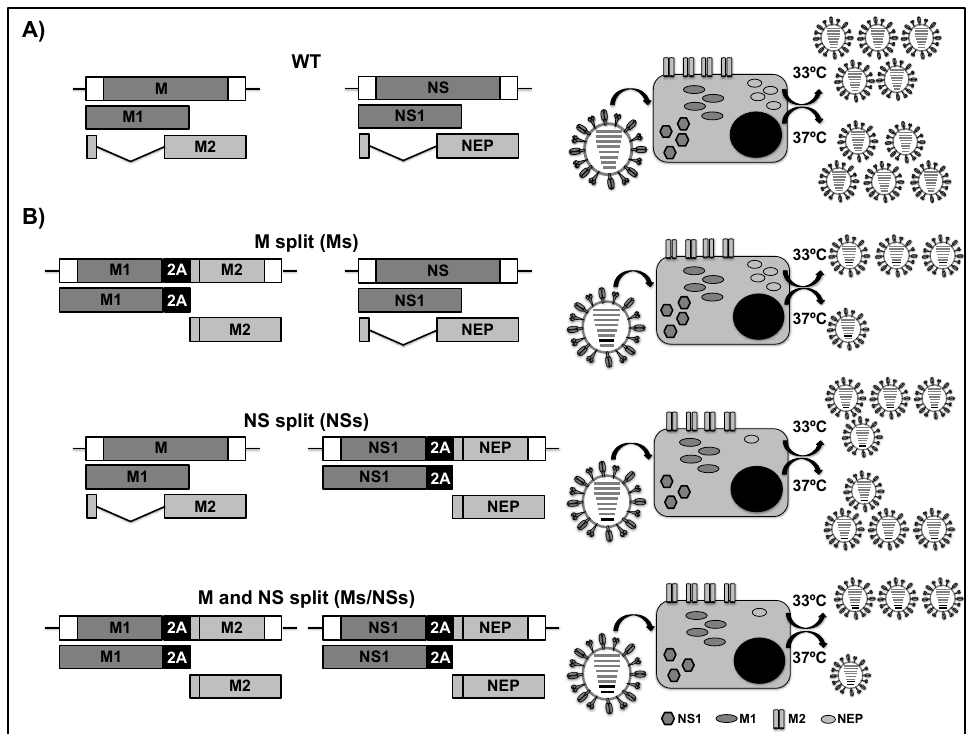
Figure 8. Development of LAIV based on modification of the spliced viral RNA segments 7 (M) and 8 (NS): Schematic representation of WT (A) and modified (B) viral RNA segments 7 (Ms, top), 8 (NS, middle), or both 7 and 8 (Ms/NSs, bottom) in which the overlapping ORFs of the M1 and M2 proteins (Ms, top), NS1 and NEP proteins (NSs, middle), or both (Ms/NSs, bottom) are produced from the same transcript by using the PTV-1 2A autoproteolytic cleavage site. Viral products from the M (M1 and M2) and NS (NS1 and NEP) WT ( A ) or modified ( B ) viral segments are indicated in grey boxes. M2 ORF is shown as a lighter grey